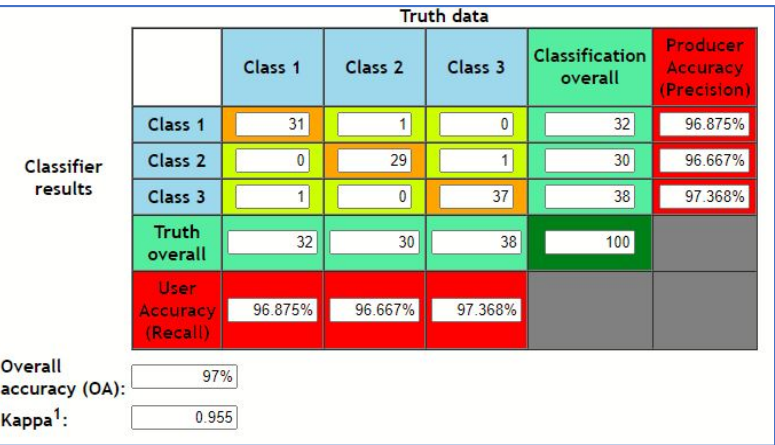
Figure 4. RF Classifier Performance. The accuracy of Random Forest is 97% as shown in the truth table (Figure 4).